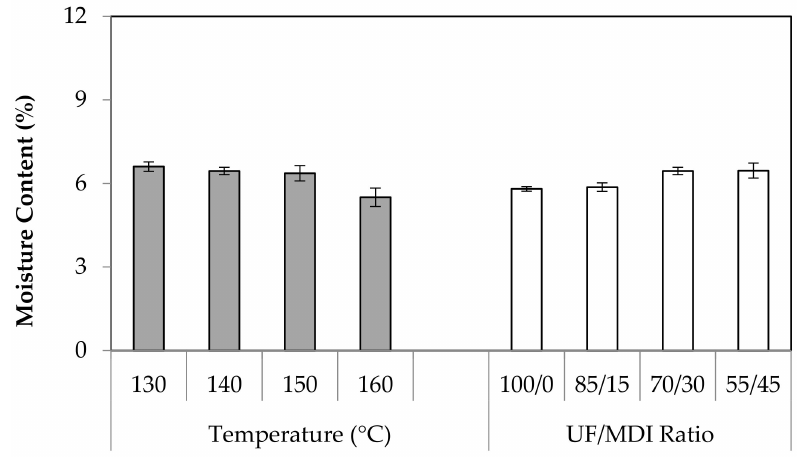
Figure 4. Moisture content of the particleboard. The bars indicate the standard deviation.